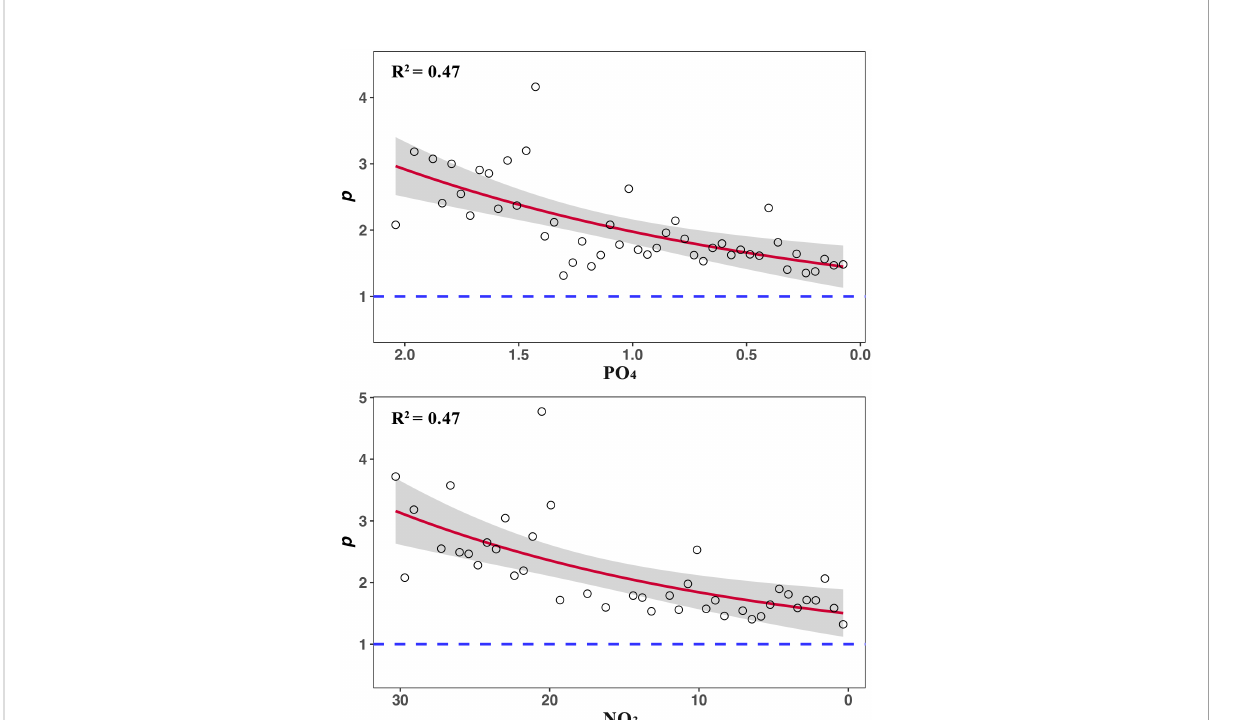
FIGURE 2 The relationships between nutrient concentrations (µmol/L) and fractal p . The red line represents the result of non-line regression and the gray shading represents the 95% con fi dence limits (PO 4 : y = 0.81e 0.52 x + 0.61, R 2 = 0.47, P< 0.01; NO 3 : y = 0.72e 0.04 x +0.77, R 2 = 0.47, P< 0.01).